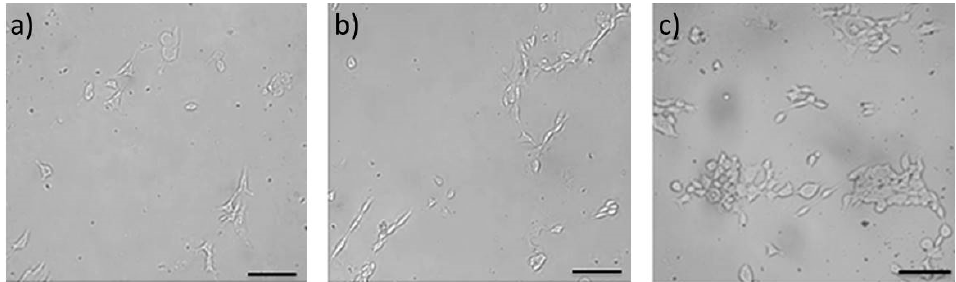
Figure 11. Using an optical microscope to observe morphology of HEK 293 cells cultured on sterilized SF / GA / Gly / Cur composite films with a cell seeding density of 10 4 cells / cm 2 after 24 h ( a ), 48 h ( b ), and 72 h ( c ) of culturation. Scale bars: 100 µ m.